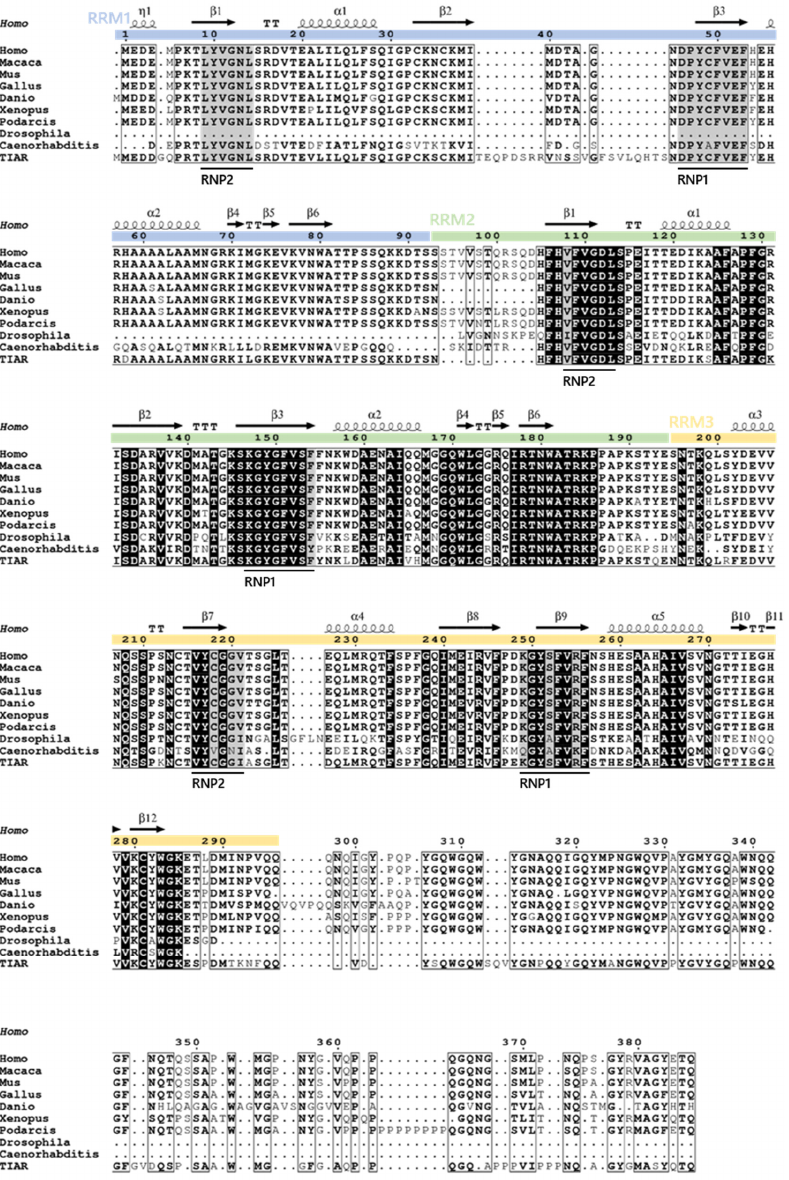
Figure 3. Profound conservation of TIA1 orthologs. Sequence alignment of TIA1 from different species, as well as human TIAR. Original sequences used in the analysis: Homo sapiens (Human) TIA1, NP_071505.2; Macaca mulatta (Rhesus monkey) TIA1, NP_001248687.1; Mus musculus (Mouse) TIA1, NP_035715.1; Gallus gallus (Rooster) TIA1, NP_001244132.1; Danio rerio (Zebrafish) TIA1, NP_997793.1; Xenopus tropicalis (Western clawed frog) TIA1, NP_989276.1; Podarcis muralis (Lizard) TIA1, XP_028597015.1; Drosophila melanogaster (Fruit fly) DmeI, NP_001303550.1; Caenorhabditis elegans (Nematode) RRM domain-containing protein, NP_495121.1; Homo sapiens (Human) TIAR, NP_001029097.1. Positions with strictly conserved residues show a black background with white letters and the ones with well conserved residues have a grey background, with the conserved residues in bold letters. Residues conserved between groups are boxed. The secondary structure of the protein, as well as the RRM domains, are shown above the